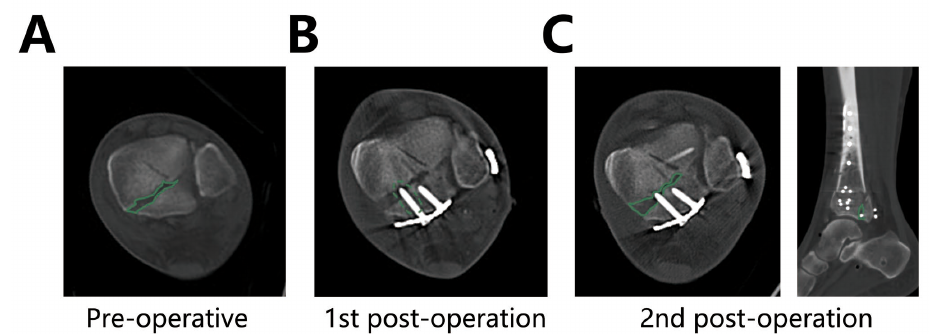
Figure 1. Inappropriate length of the screws impedes Volkmann fragment repositioning. ( A ) The CT scan shows the morphology of the preoperative pilon fracture bone fragments. ( B ) The posterior screws should be shorter than the size of the posterior ankle fragment. ( C ) CT scan of the ankle after the second surgery showed that an excessively long posterior screw impeded the reduction of the anterolateral bone fragments during the second surgery.